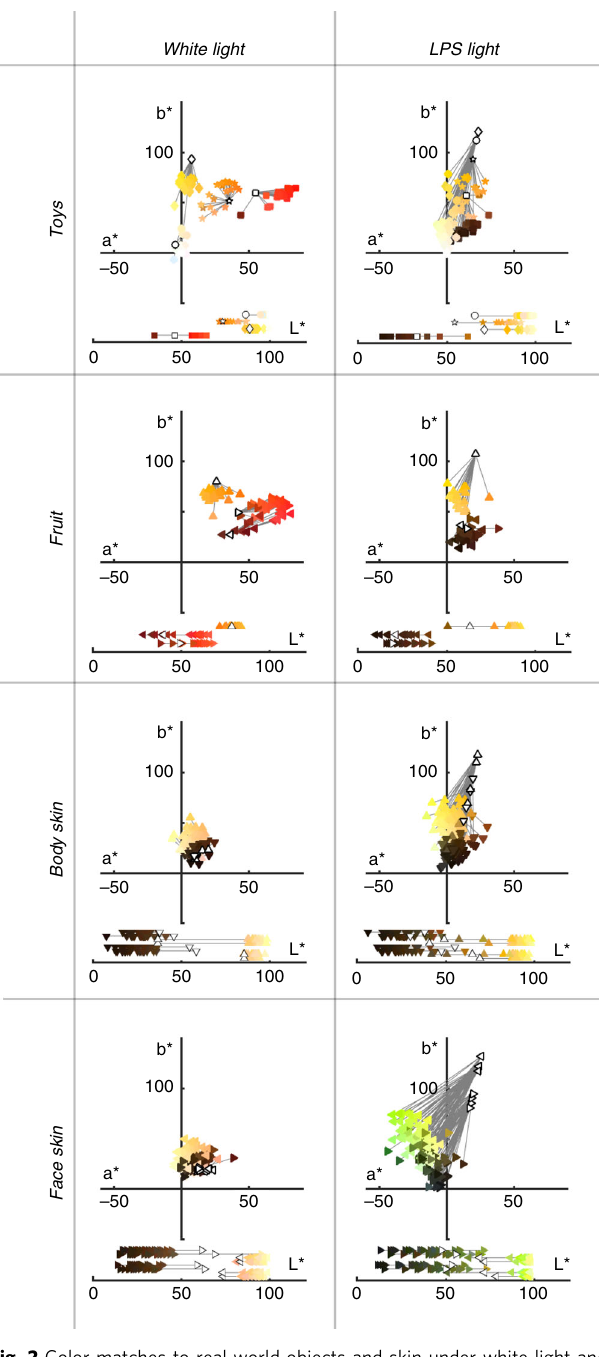
Fig. 2 Color matches to real world objects and skin under white light and low-pressure sodium light. Participants ’ ( N = 20) color matches to toys (square = red Lego; diamond = yellow Lego; star = orange toy phone; circle = ping-pong ball), fruit (right-facing triangle = tomato; left-facing triangle = strawberry; upward triangle = orange), body skin (hand, neck of four actors; downward triangle = African American; upward triangle = Caucasian), and face skin (check, forehead of four actors; rightward triangle = African American; leftward triangle = Caucasian). Lines connect matched values (colored markers) to the spectroradiometric measurements (open markers). Spectroradiometric measurements were transformed to L * a * b * using the Macbeth white card under white light as the white point, CIE XYZ = [27.9446 25.0000 10.5134]). Matched values were transformed from RGB to CIE L * a * b * using the chromaticity coordinates of the monitor, gamma corrected. Source data are provided